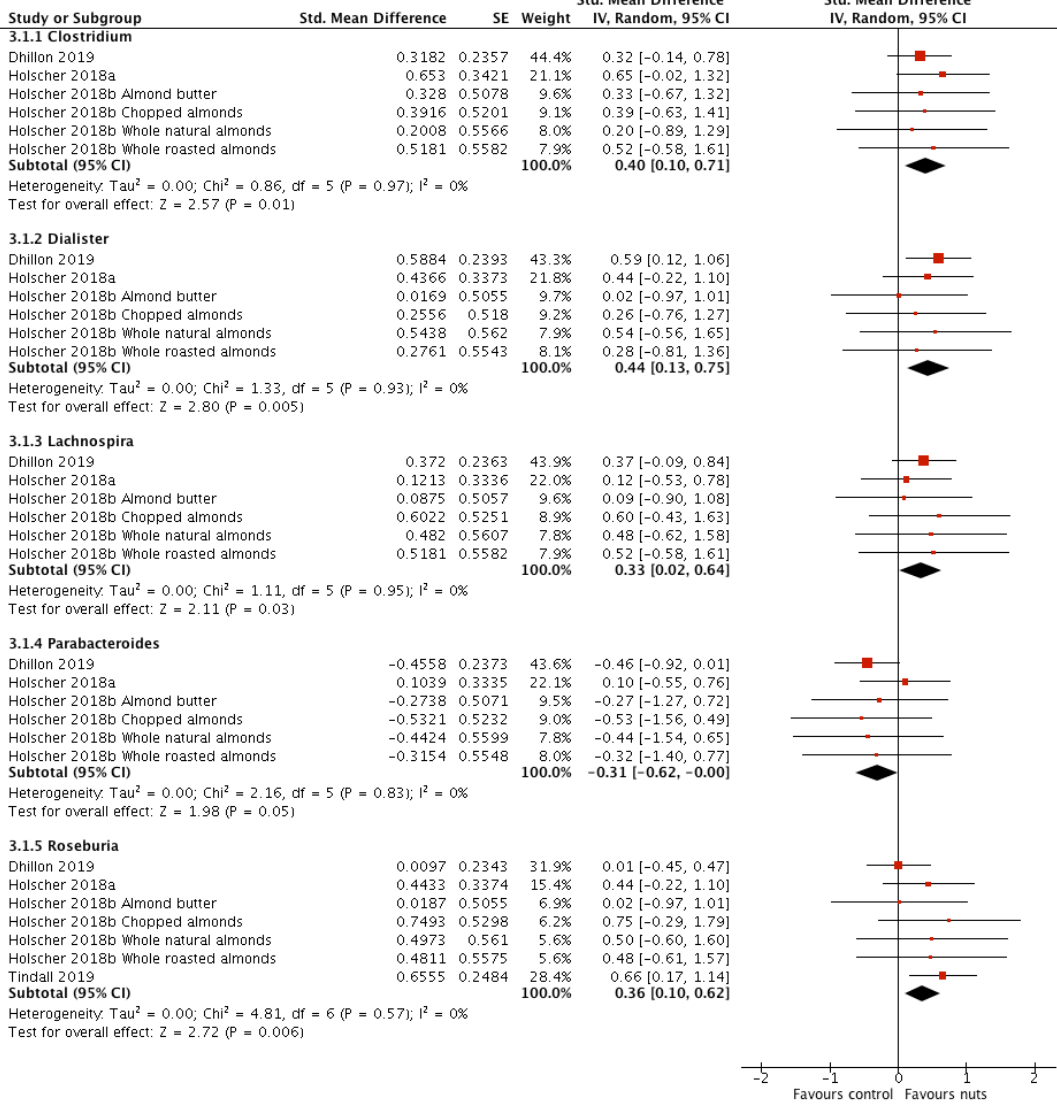
Figure 3. Forest plot of relative abundance of bacterial genera measured in faecal samples of participants taking part in randomised controlled trials comparing nut consumption to control in adults. Meta-analyses were conducted using a random effects model. Only statistically significant differences are shown. Values are standardised mean difference (95% confidence interval).